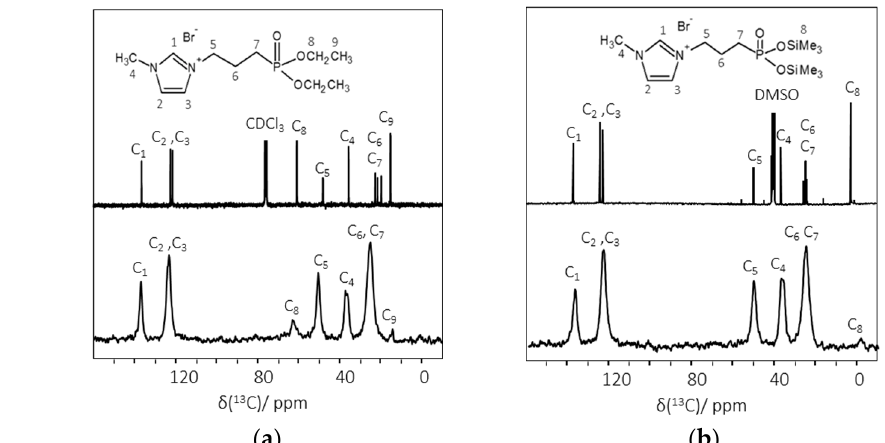
Figure 4. 13 C CP-MAS NMR spectra of pure ionic liquids (I) and the γ -Al 2 O 3 grafted samples (II) prepared under the different reaction conditions. Comparison between: ( a ) pure ImPE and ImPE4 (130 ˝ C, 17 h, 12-fold excess); ( b ) pure ImTMSP and ImTMSP4 (six-fold excess, 72 h).